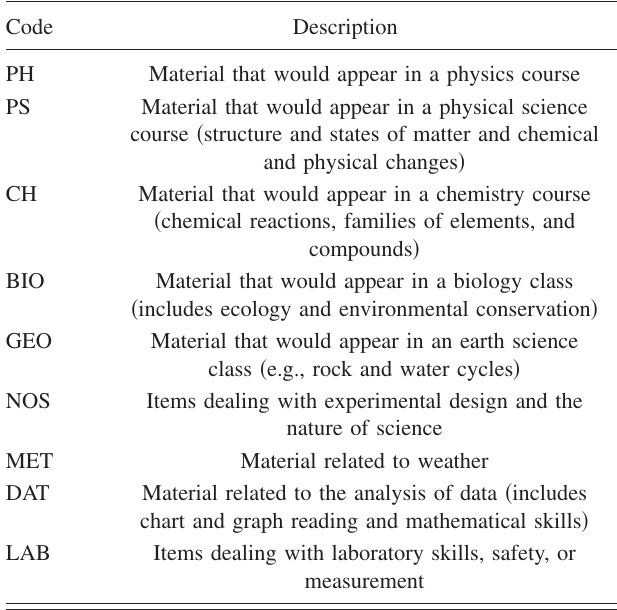
TABLE I. Codes resulting from the primary round of open cod- ing for the content area of items from the 2003 and 2004 TAKS